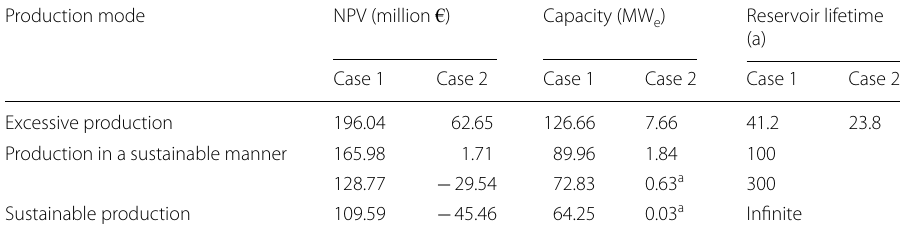
a Values outside the defined range of the cost function, which results in a slight increase in both the surface and O&M